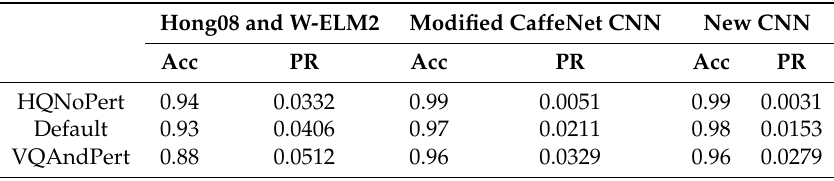
Table 5. Comparison of the results achieved by the best combination (feature extractor and type of ELM), the modified CaffeNET CNN [3,30], and the CNN model proposed in [3].